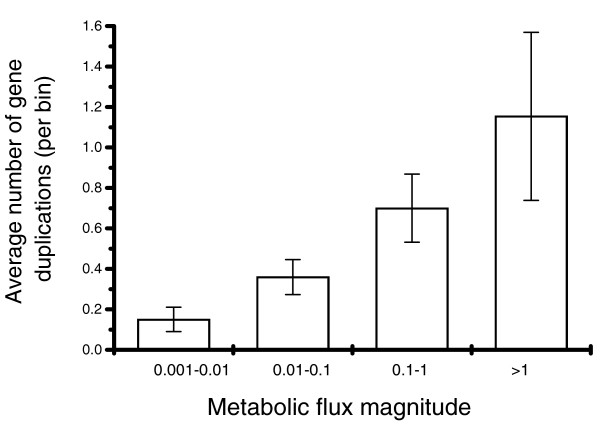
The relationship between the number of duplicates of an enzyme-coding gene and the magnitude of the metabolic flux through the enzymatic reaction. The results are shown for aerobic growth on glucose (maximal uptake rate for glucose 15.3 mmol/gDW/h; oxygen 0.2 mmol/gDW/h). Putative duplicate pairs with less than 40% amino acid similarity or less than 100 aligned amino acid residues were excluded.